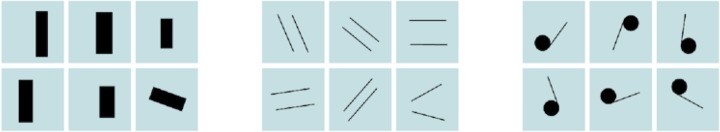
Sample images from the visual form analysis task.